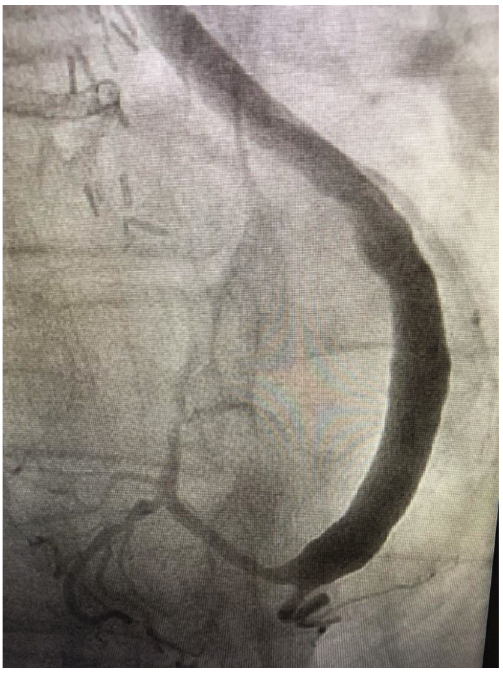
Figure 1: Initial cardiac angiogram of the fi rst OM/terminal circum fl ex with high clot burden theorized to be due to venous out fl ow mismatch from